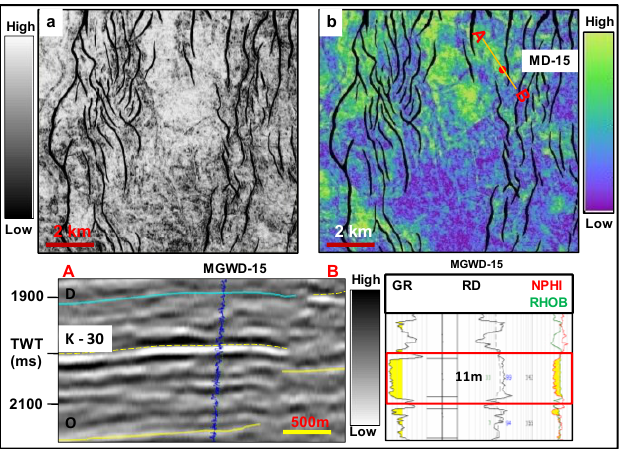
Figure 10: Semblance map (a) and RMS overlay on semblance map (b) at horizon O-100. The seismic section along A-B shows that channel shape is